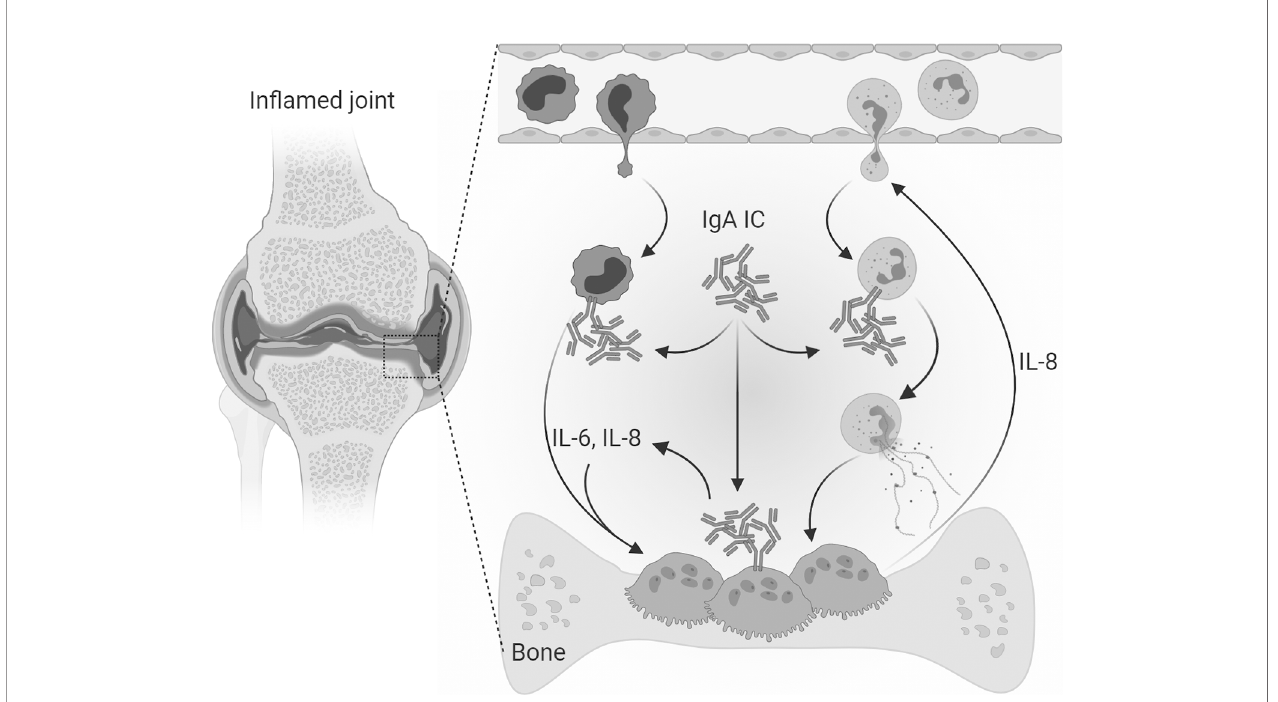
FIGURE 6 | Mechanism of direct and indirect IgA-mediated osteoclast activation. In the in fl amed joints of RA patients ’ immune complexes consisting of IgA autoantibodies are present. In fi ltrated neutrophils can form neutrophil extracellular traps (NETs) when activated with IgA-containing immune complexes. Monocytes activated with IgA-containing immune complexes produce high levels of IL-6 and IL-8 and enhance the bone resorptive capacity of osteoclasts. IgA-containing immune complexes can also directly target osteoclasts which express the Fc receptor for IgA (Fc a RI). After IgA activation osteoclasts secrete IL-8 and IL-6, which are osteoclastogenic cytokines known to contribute to the formation of osteoclasts. Furthermore, IL-8 contributes to the chemoattraction and in fi ltration of neutrophils thereby enhancing the pro-in fl ammatory environment in the in fl amed synovium of RA patients. Osteoclast secreted IL-8 could therefore both lead to auto stimulation and attraction of neutrophils to the in fl amed area. [Created with